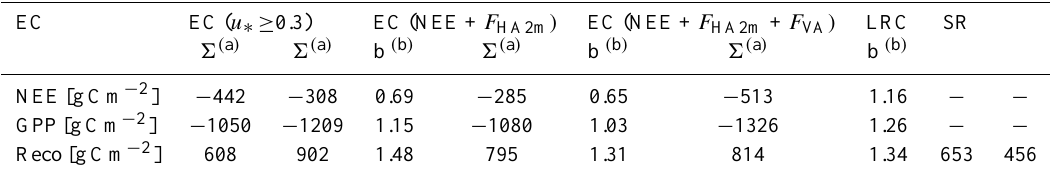
Table 2. Cumulative sums of NEE, GPP and Reco for May to August 2007 based on EC data and different correction approaches for the forest site L¨ageren.